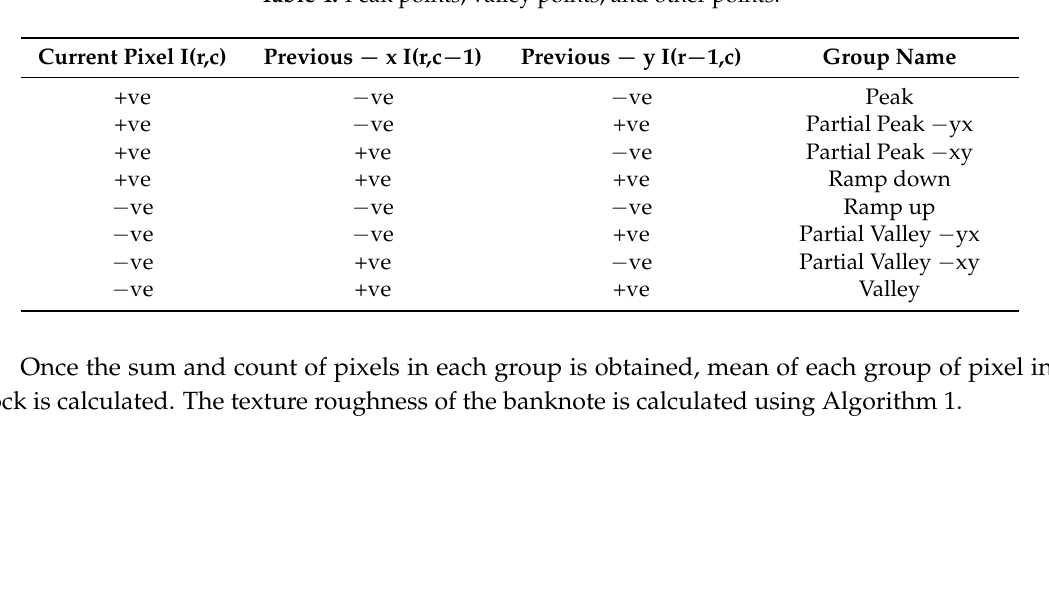
Table 4. Peak points, valley points, and other points.